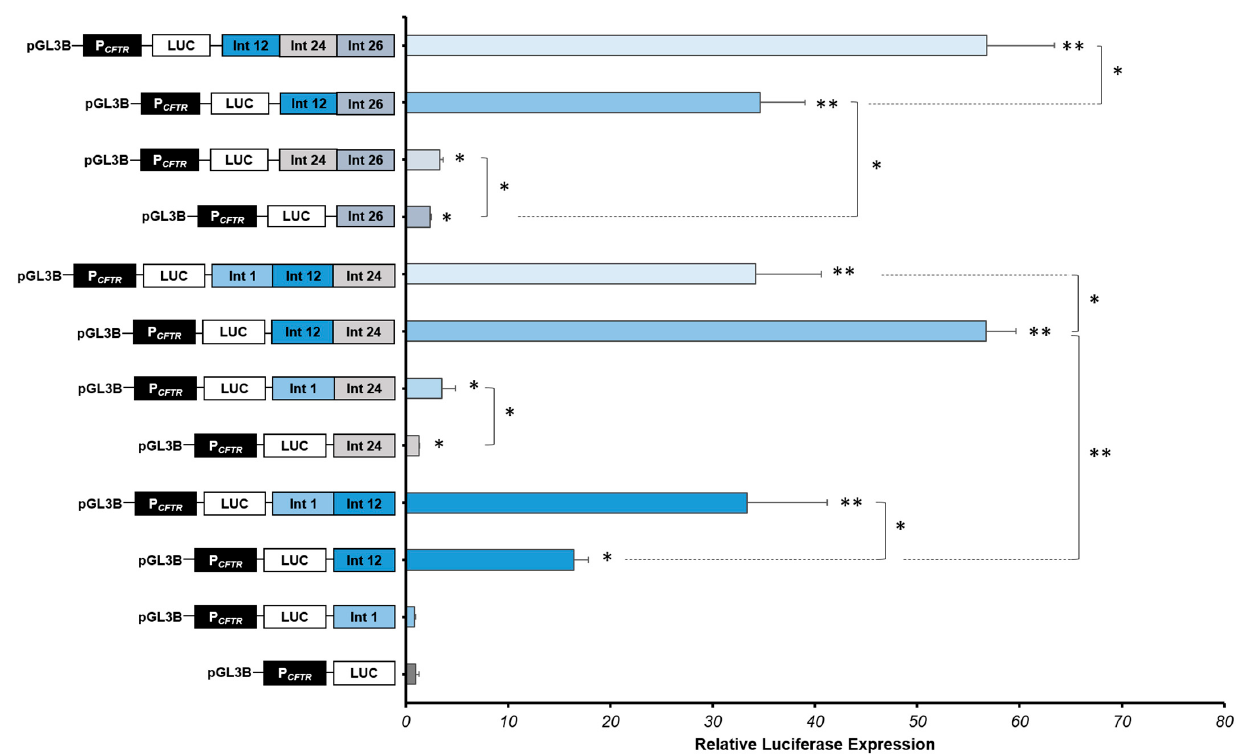
Figure 4. Strong cooperative effects between CFTR introns CREs in intestinal cells. Luciferase reporter constructs with the CFTR promoter (P CFTR ; 787 bp) and cis -regulatory elements combined or alone (DHS Intron 1:Int 1; DHS Intron 12:Int 12; DHS Intron 24:Int 24; DHS Intron 26:Int 26) were transfected in intestinal cells Caco-2. Enhancers of introns 1 and 12 of the CFTR gene are positive controls. Luciferase expression values were reported at β -galactosidase expression values (control of transfections). Error bars represent the standard error of the mean (SEM; n = 9), * p < 0.002, ** p < 10 − 10 using unpaired t-tests.